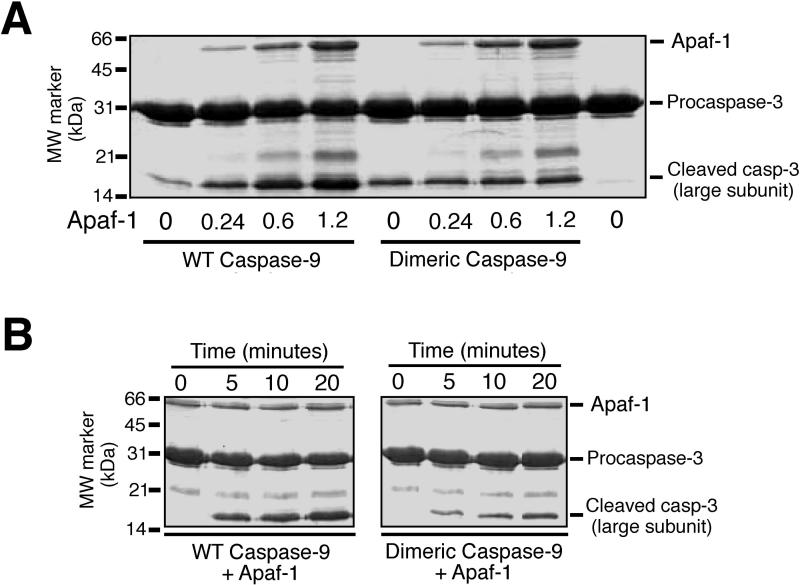
The Dimeric Caspase-9 Can No Longer Be Activated the Same Way as the WT Caspase-9(A) Increasing amounts of Apaf-1 (residues 1–570) led to a corresponding increase in the catalytic activity of the WT caspase-9, but had no effect on the activity of the dimeric caspase-9. WT and dimeric caspase-9, 0.5 μM; procaspase-3 (C163A), 33 μM; Apaf-1, 0.24, 0.6, and 1.2 μM.(B) A time course of procaspase-3 cleavage by the WT and dimeric caspase-9 in the presence of Apaf-1. WT and dimeric caspase-9, 0.3 μM; procaspase-3 (C163A), 33 μM; Apaf-1, 0.3 μM.